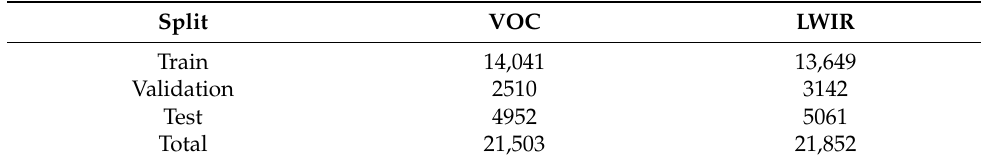
Table 1. Number of images per